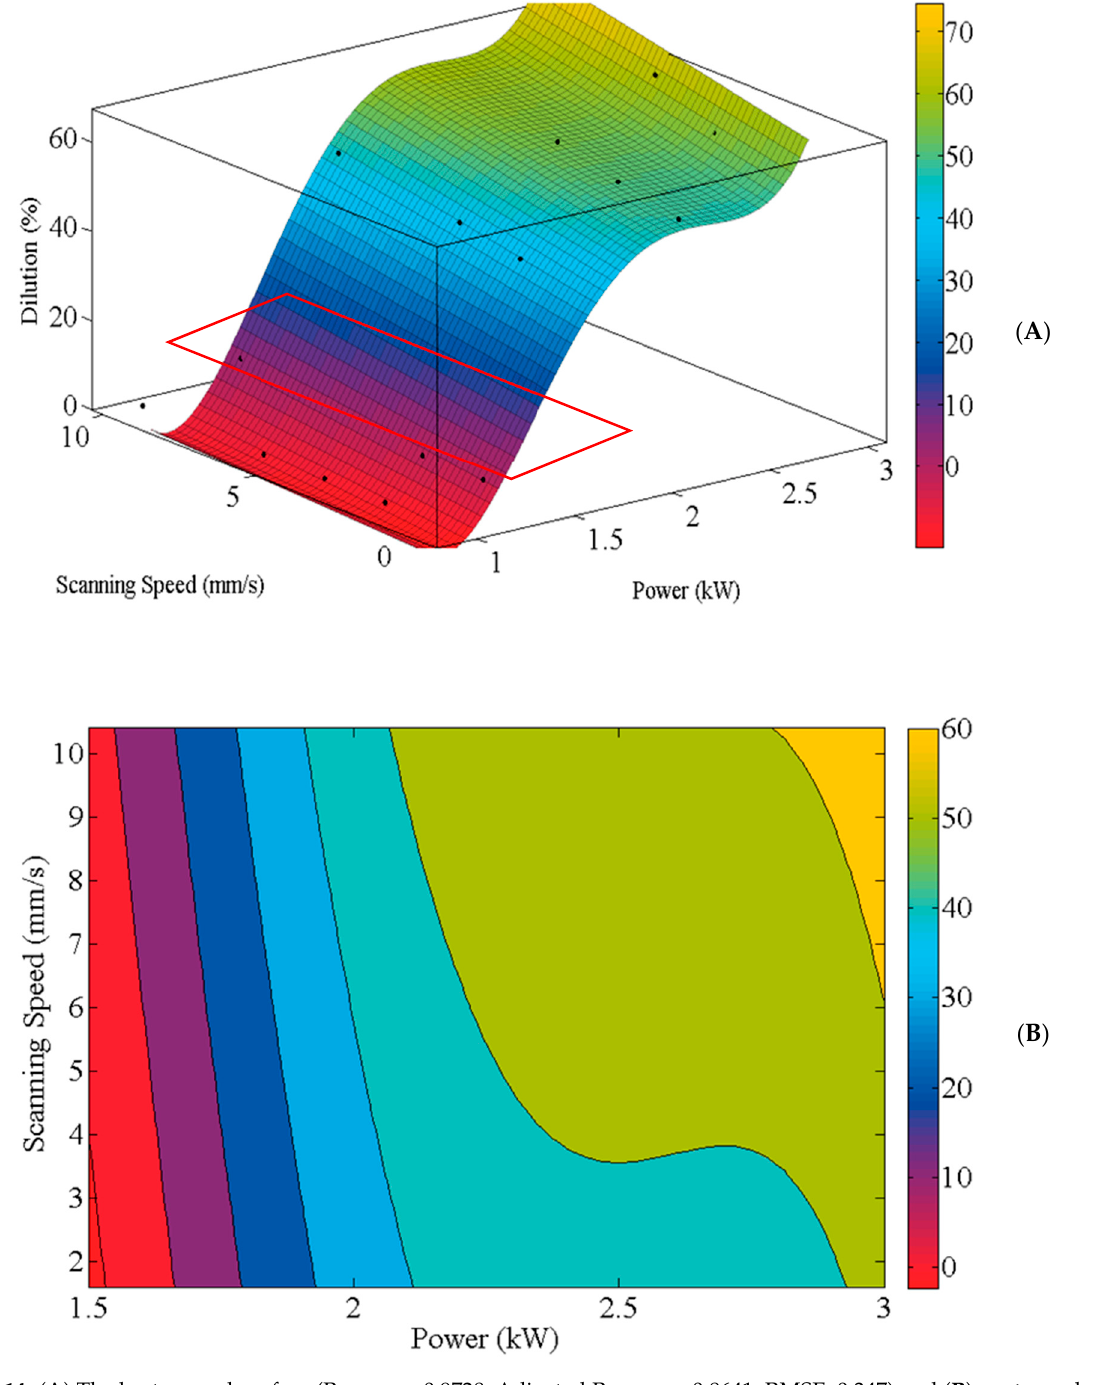
Figure 14. ( A ) The best curved surface (R-square: 0.9728; Adjusted R-square: 0.8641; RMSE: 0.347) and ( B ) contour plot for the dilution (in %) of deposited clad regarding the combination of the laser power and scanning speed. Figures 15 and 16 illustrate derived Pareto frontiers [38] minimizing the three objective functions simultaneously for samples without preheating and with 300 ◦ C preheating, respectively.